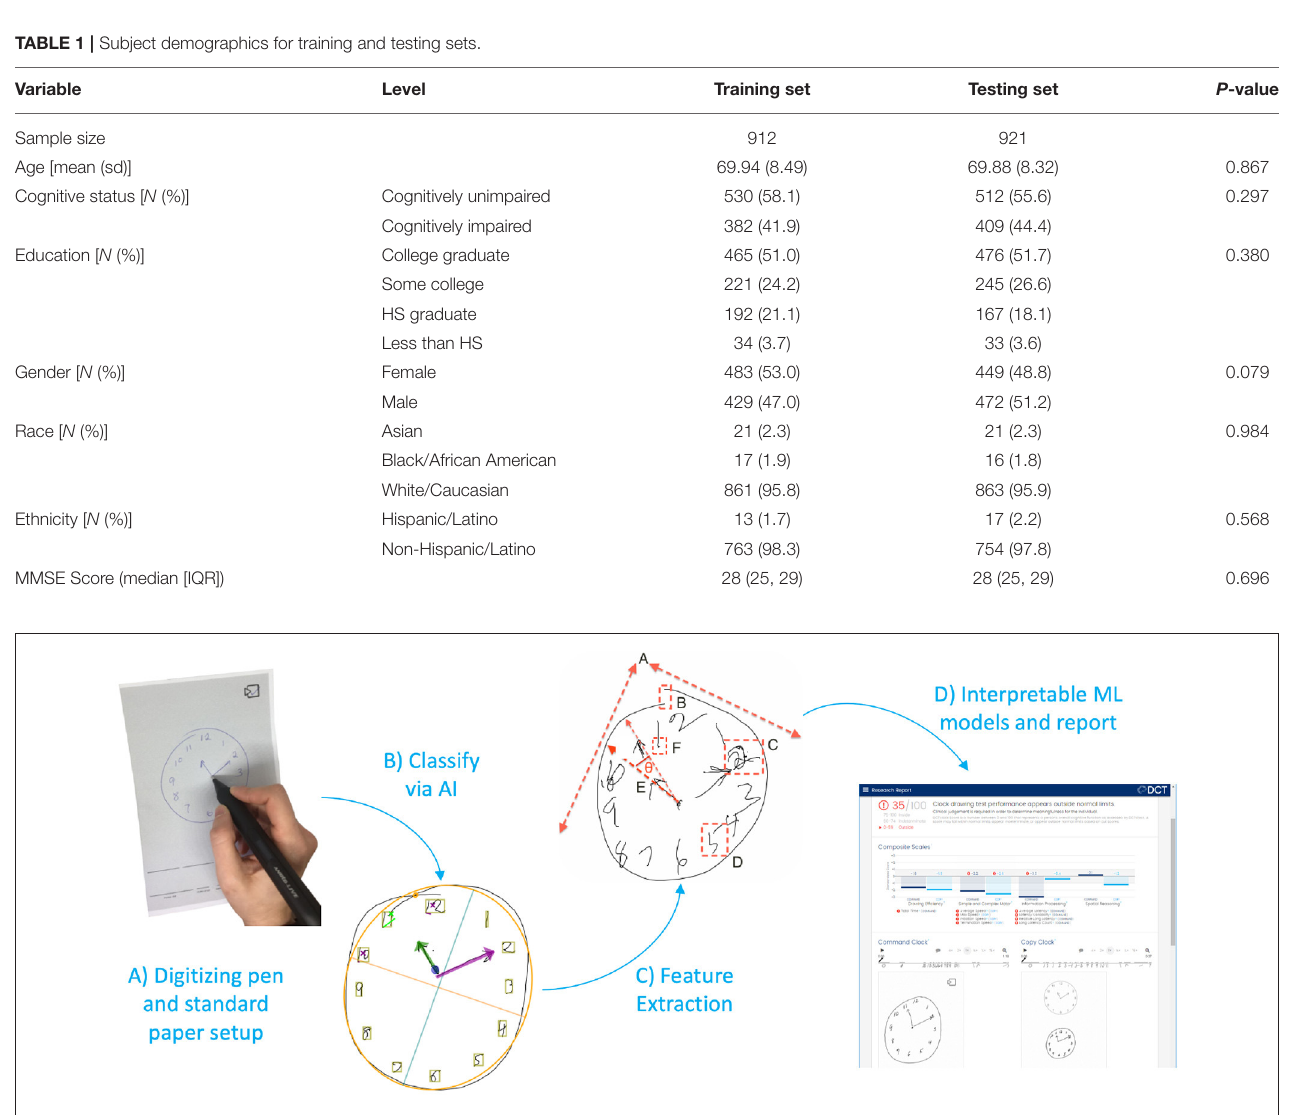
FIGURE 1 | DCTclock automated analysis steps. (A) Digitizing pen and standard test paper to capture timestamped-coordinates of drawing motion. (B) Time-stamped pen stroke coordinates are classified into drawing symbols. (C) Using knowledge from the classified strokes, low-level features are extracted from the drawing process. (D) Low-level features are combined into a set of interpretable Composite Scales and an overall score of test